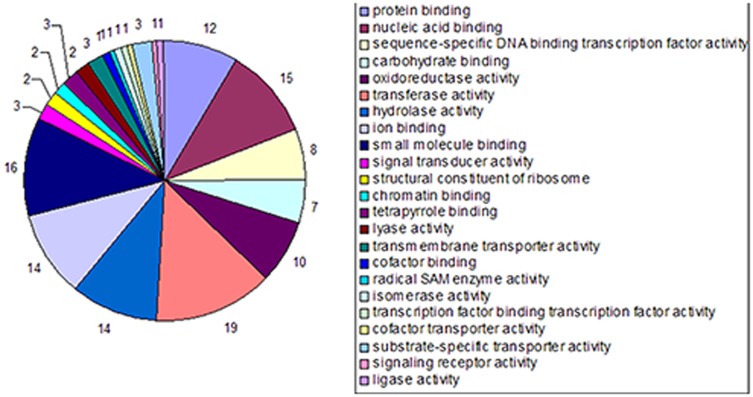
Categorization of 179 transcripts based on molecular function.